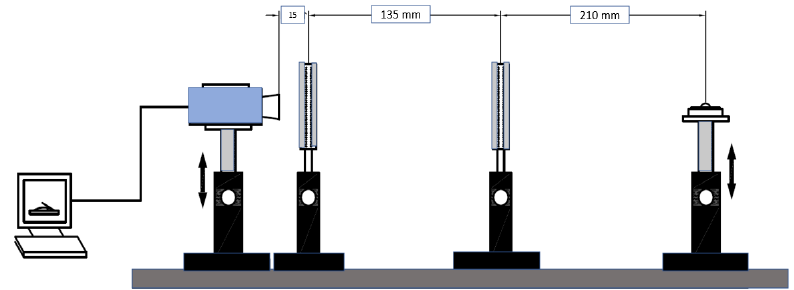
Figure 2. Critical distances between contact angle testing device.